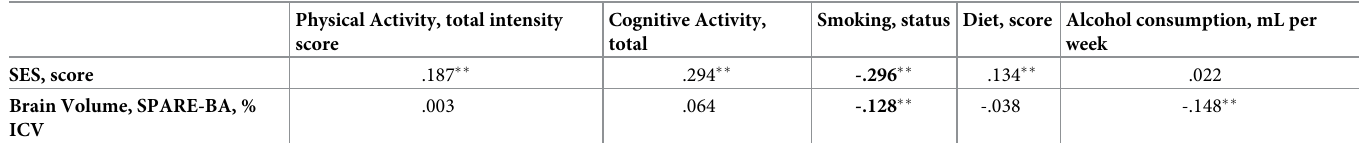
Table 3. Bivariate correlations.